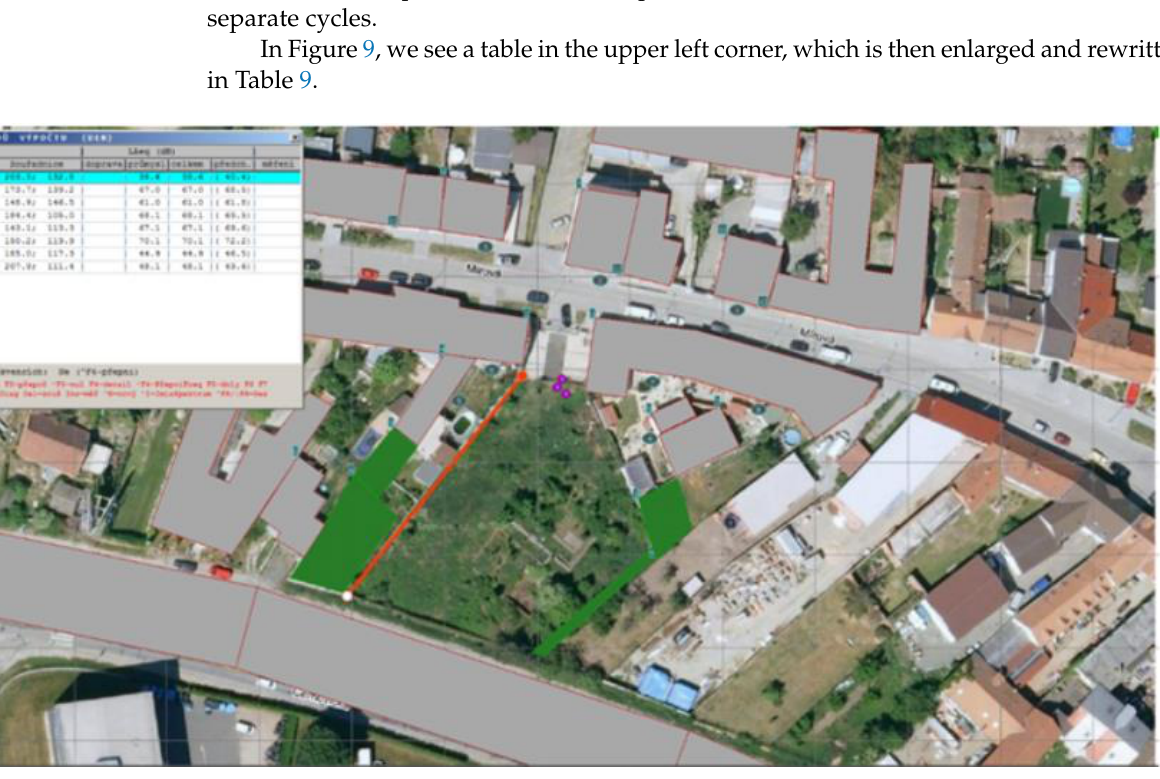
Figure 9. Acoustically significant elements (without construction site fencing or a solid gate) for earthworks during the execution of connections in the investigated area, with a table of values. Table 9. Table of calculated values of measured points with the simultaneous deployment of ma- chines shown as previous values; after the separation of excavation work from material removal, the values shown are only for excavations with an excavator.